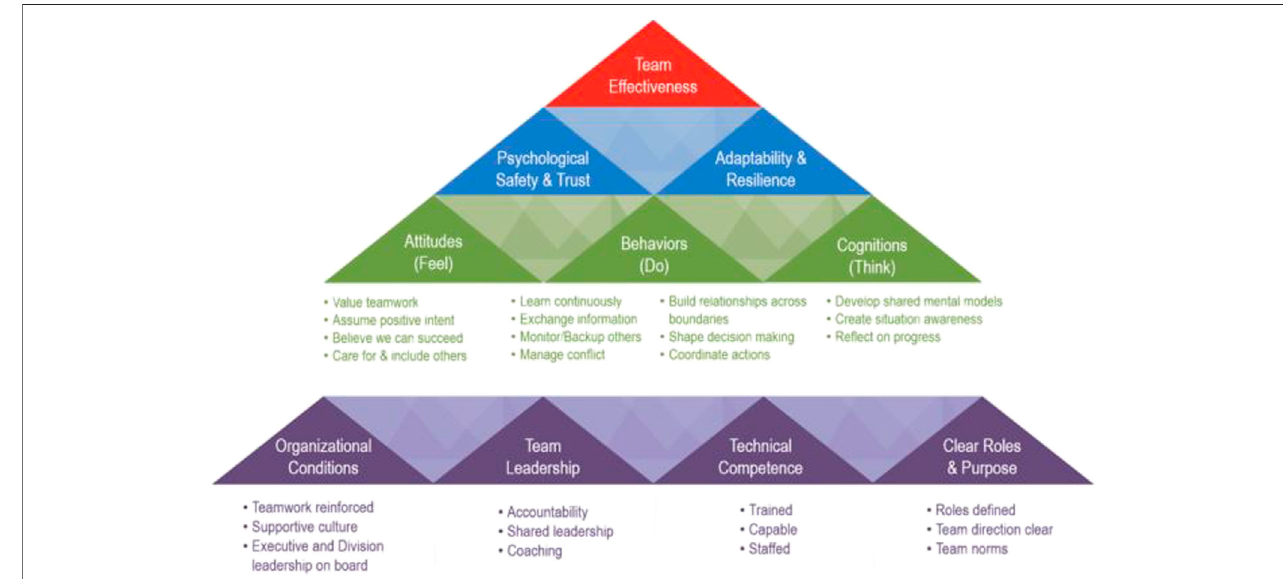
FIGURE 1 | Comprehensive Team Effectiveness